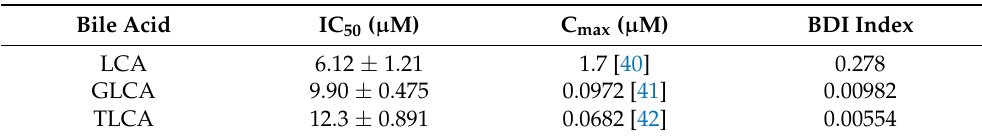
Table 2. BDI indices of LCA, GLCA, and TLCA.